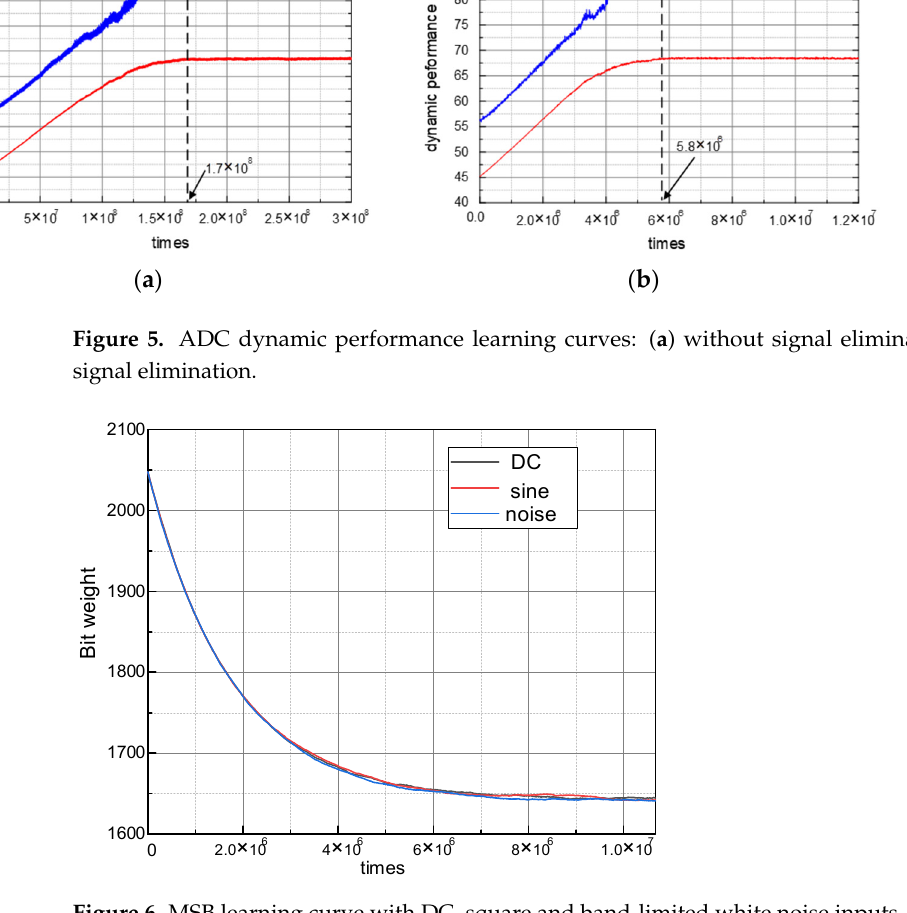
Figure 6. MSB learning curve with DC, square and band ‐ limited white noise inputs.